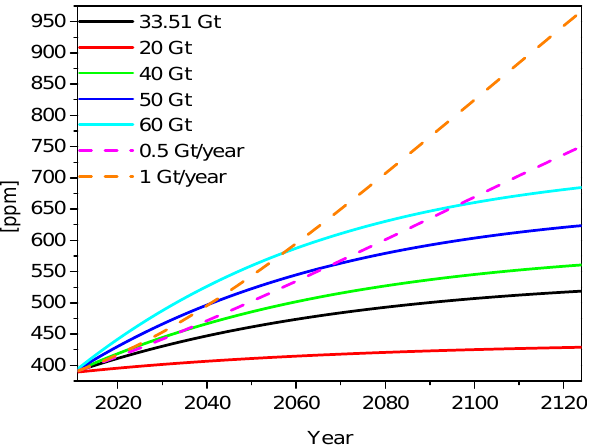
Fig. 4. CO 2 increase for constant emission rates (solid curves), starting from the present atmospheric CO 2 level of 388.56ppm for the parameters of the lifetime formula derived above. The dashed curves represent the increase of CO 2 if the emission rates continu- ously increase at a rate of 0.5Gtyr − 1 and 1Gtyr − 1 , starting from the present value of 33.51Gtyr − 1